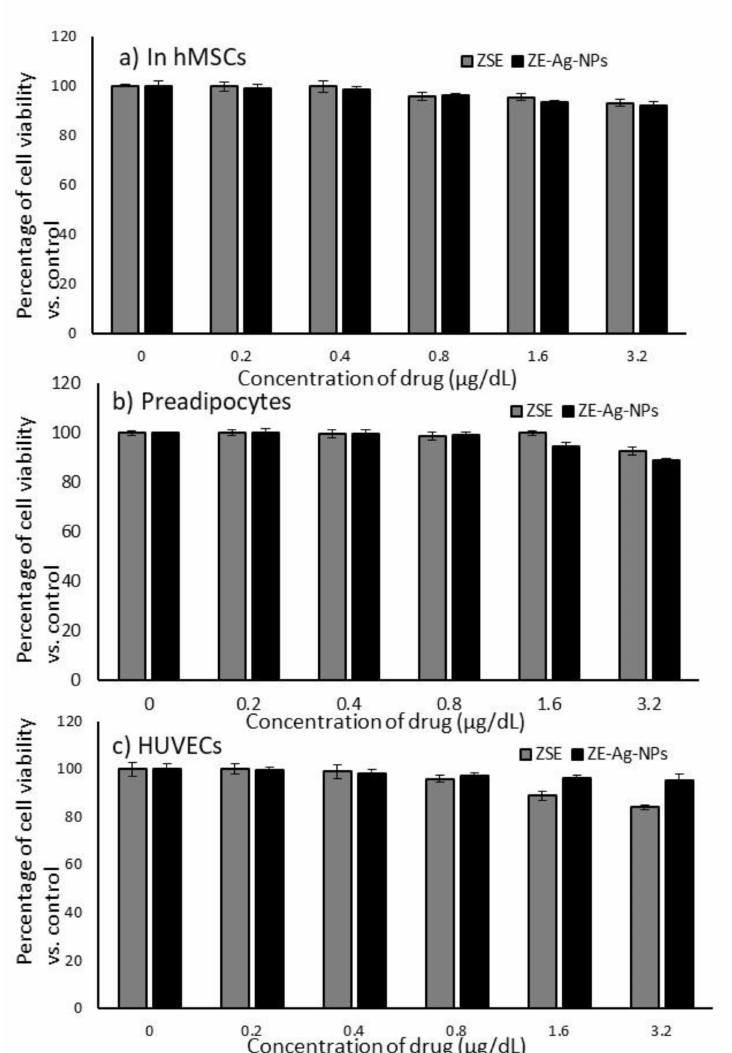
Figure 2. In vitro cytotoxic effects of Ziziphus spina (jujube) root methanol extract (ZSE) and Ziziphus spina (Jujube) root loaded silver nanoparticles (ZS-Ag-NPs) on hMSCs ( a ), preadipocytes ( b ), and HUVECs ( c ) after 48 h. Each value is a mean ± SD ( n =